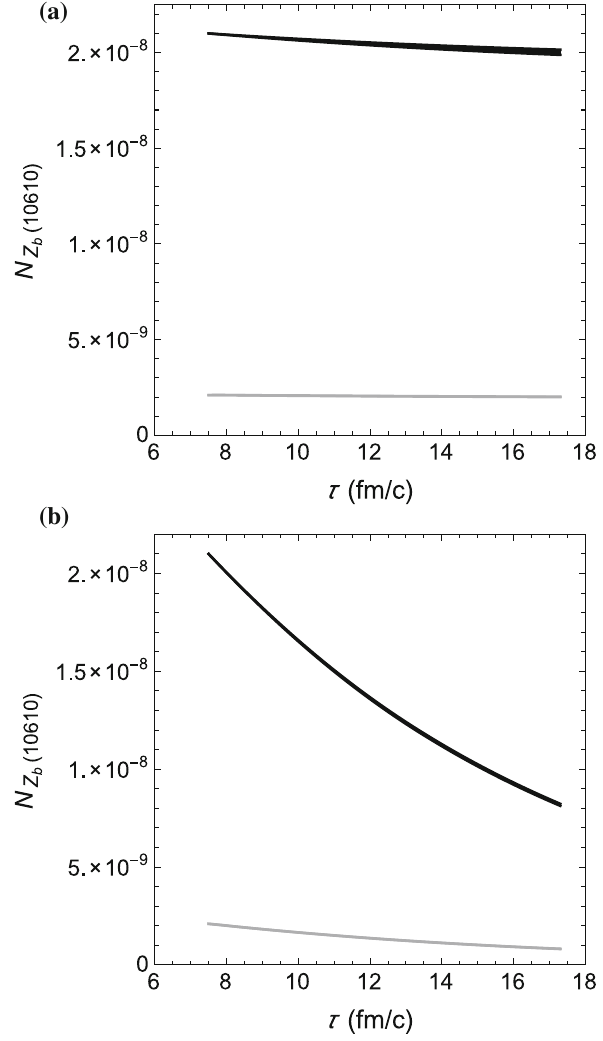
Fig. 6 a (upper panel) Time evolution of the Z b abundance as a func- √ s NN = 200GeV. tionofthepropertimeincentralAu–Aucollisionsat Dark and light shaded bands represent the evolution with the number of Z b ’s produced at the end of the quark–gluon plasma phase calcu- lated using statistical and four-quark coalescence models, respectively. b (lower panel) Same as a but including the decay of the Z